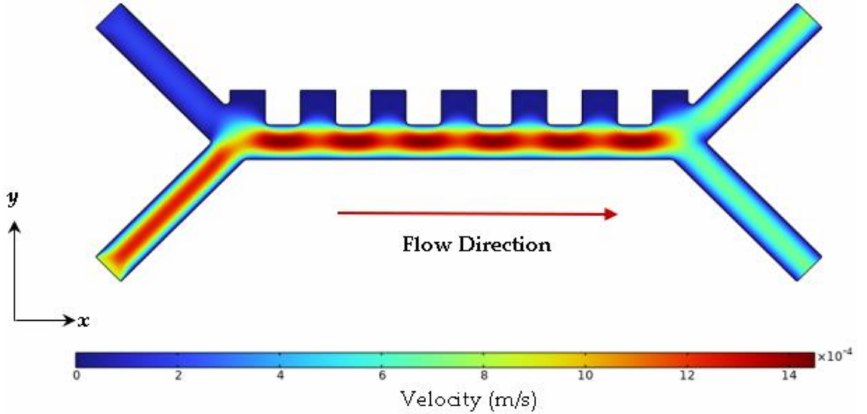
Figure 6. Contour of steady fluid flow through the y-channel